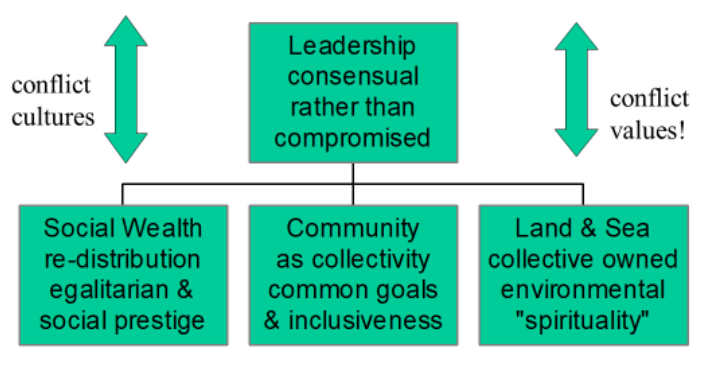
Figure 1: Indigeneity and Autonomy in Conflict with Dominant Society Model of Indigenous Relations in Four Categories of Leadership or Decision Making, Economy, Community, and Land or Environment, in Conflict with Dominant Society, Modern States